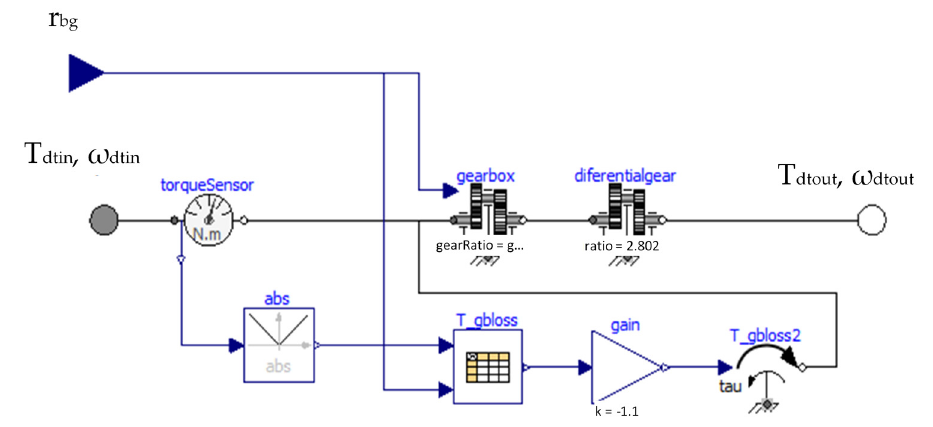
Figure 7. Diagram of the “drivetrain” module in the developed test simulation.